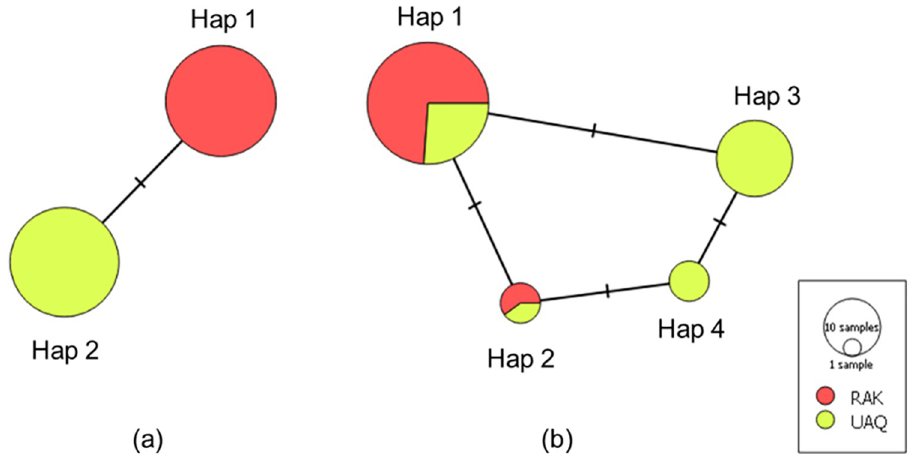
Fig 5. Minimum spanning network representing Salicornia persica haplotypes belonging to Ras-Al-Khaimah and Umm-Al-Quwain populations. (a) matK haplotype network (b) nrDNA (ITS2+ETS) haplotype network.